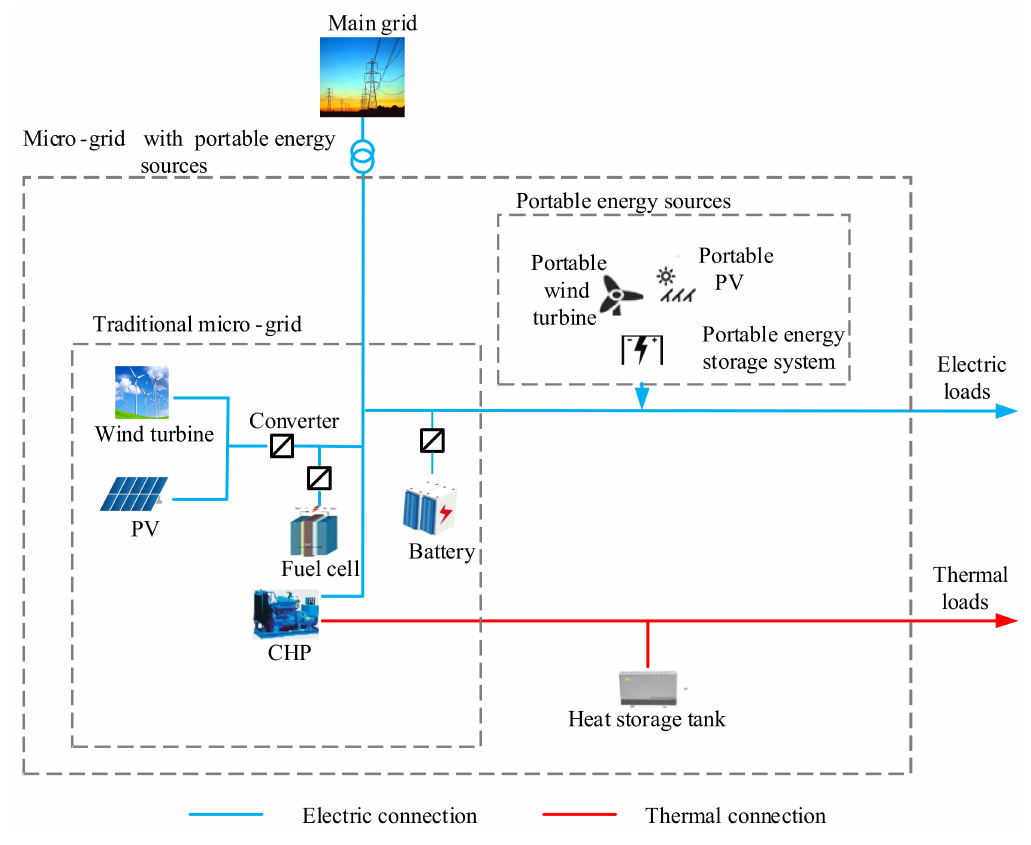
Figure 1. The structure diagram of a newly defined